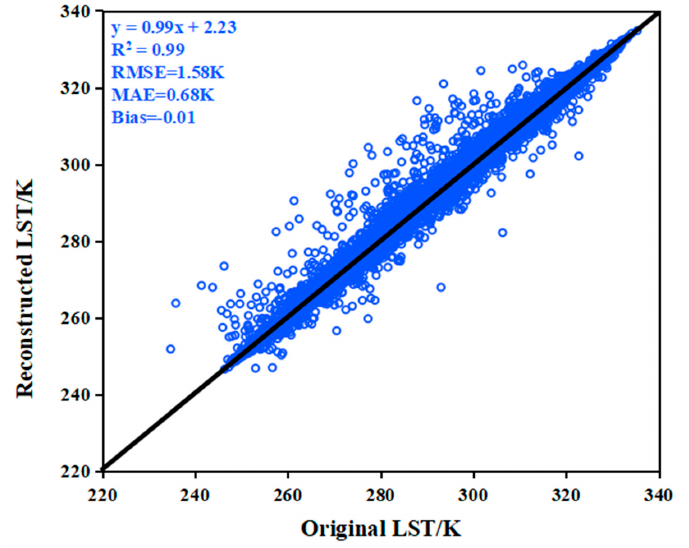
Figure 4. Scatter plot of reconstructed land surface temperature, where LST: land surface temperature. Taking the image before and after reconstruction on the 209th day of 2009 as an ex- ample, results are shown in Figure 5. It can be seen intuitively that there was a large num- ber of gaps (Figure 5a) before reconstruction. After reconstruction, almost all the gaps had been filled, and the spatial distribution was consistent with the original image. Con- sistency and good reconstruction effect proved that the method was feasible and can re- construct LST with a large amount of cloud coverage.